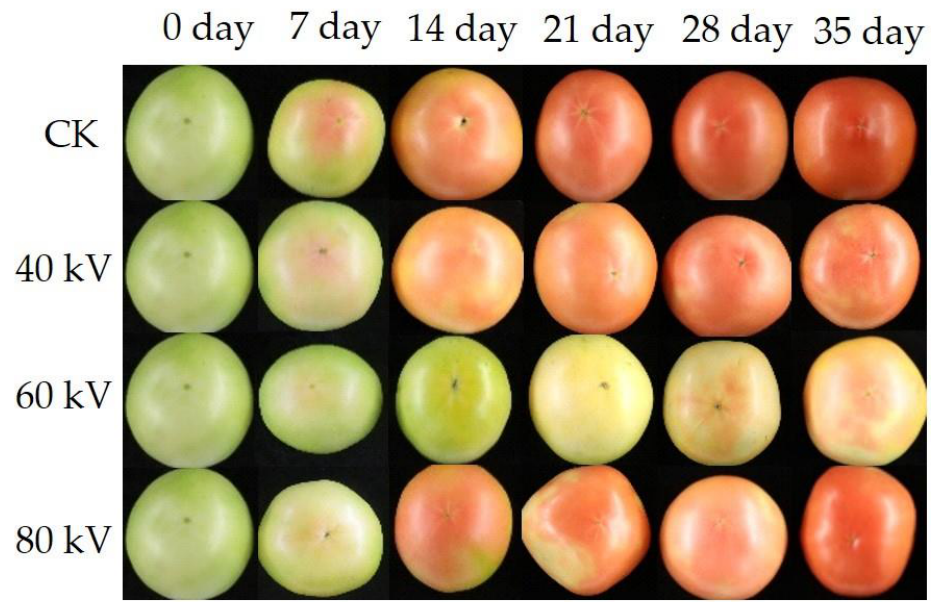
Figure 2. Effects of ACP treatment of different intensities on the apparent changes in the tomatoes. Table 2. Effects of different intensities of ACP treatment on the color of tomatoes.